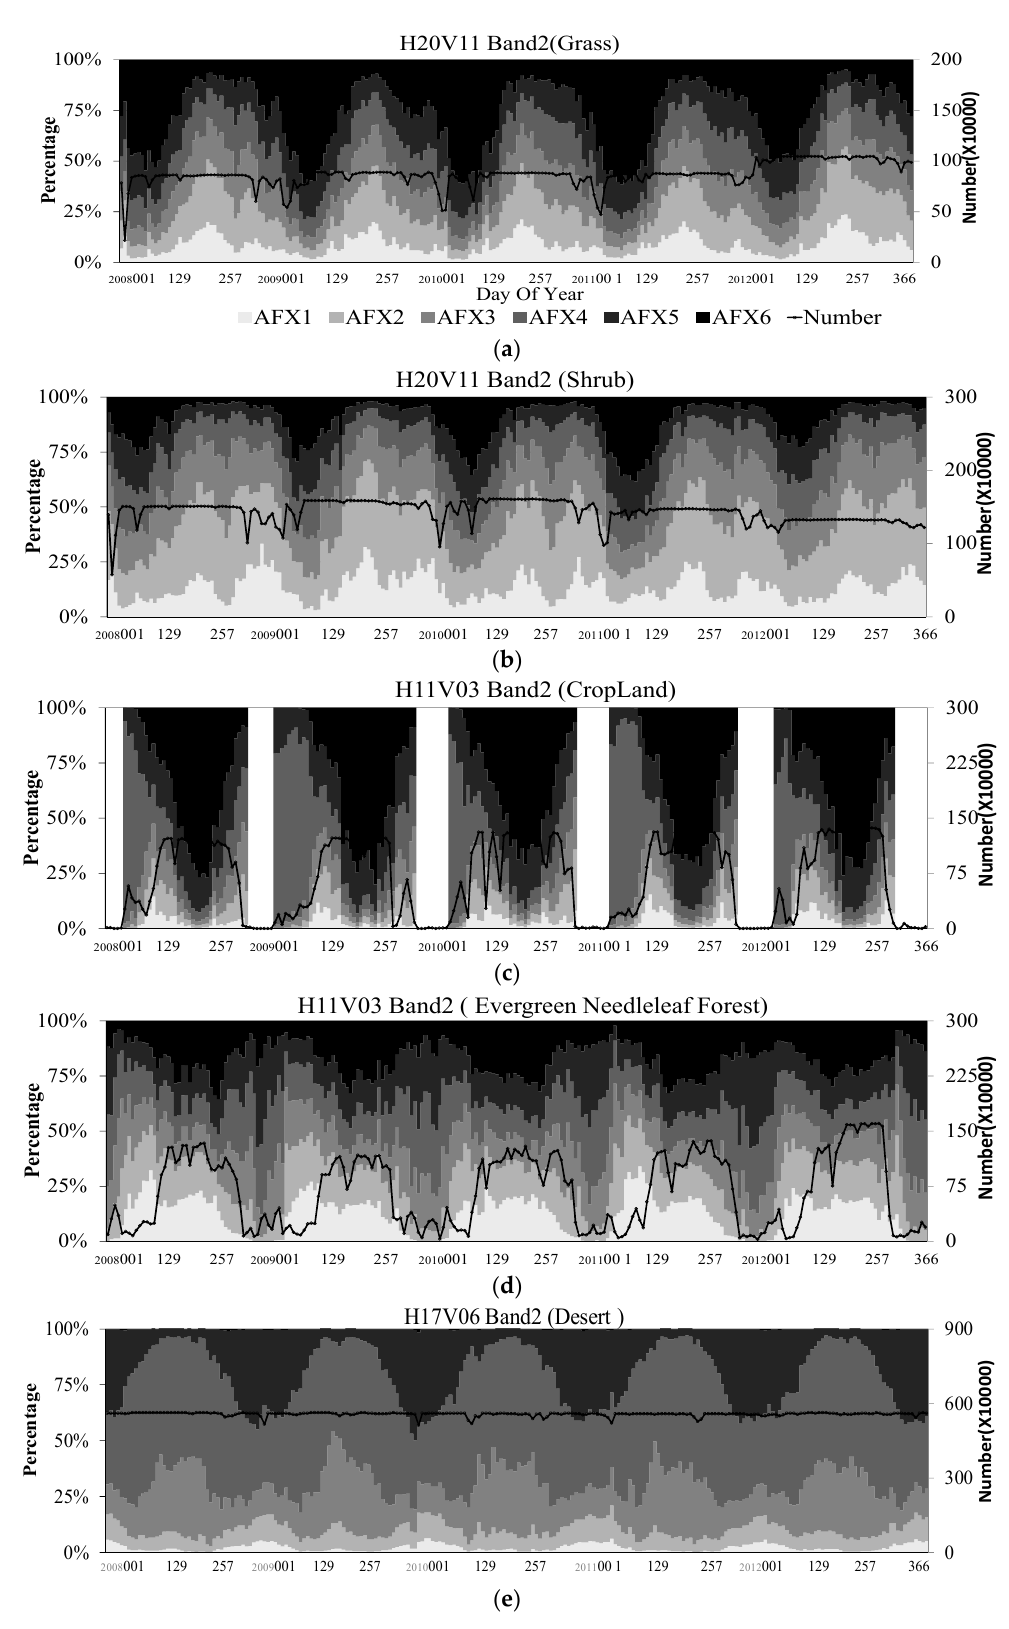
Figure 6. Cumulative histograms regarding the percentage of each BRDF archetype class within grassland ( a ); shrubland ( b ); cropland ( c ); forest ( d ); and desert ( e ) in the NIR band in three tiles from 2008 to 2012.